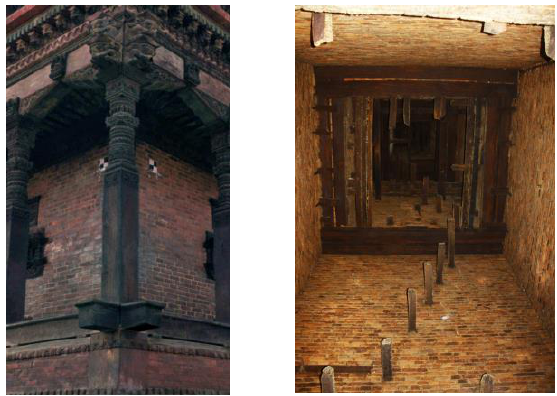
Figure 9. Detail of Column post (left) and ceiling view of inside from first-floor level (right)